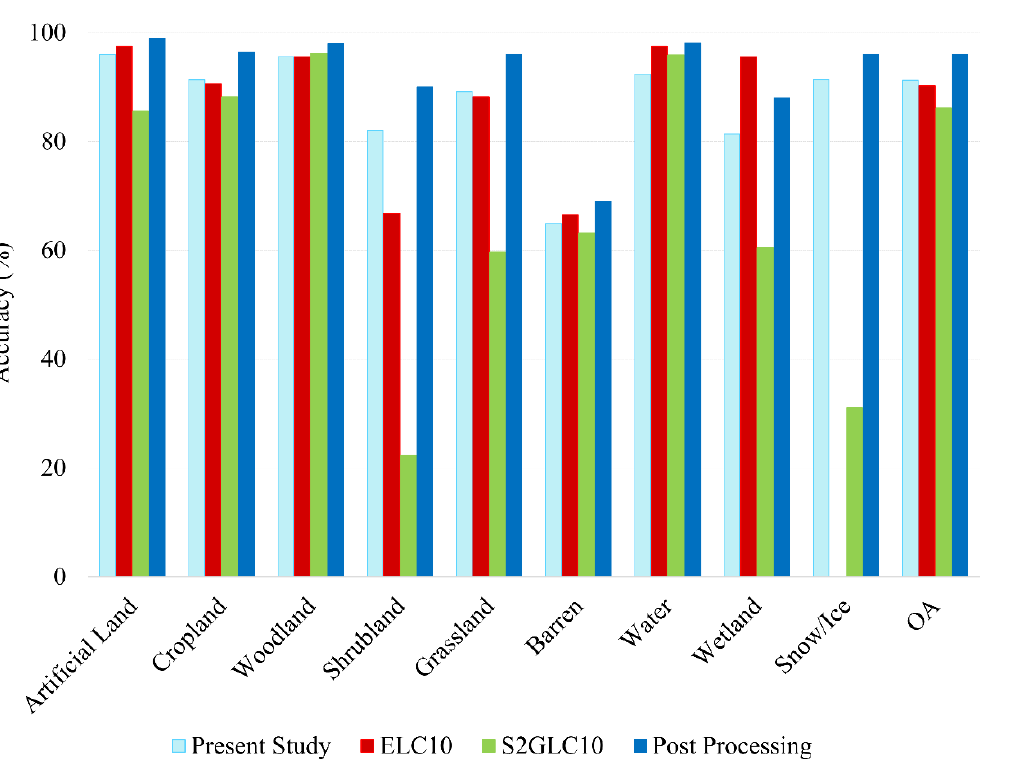
Figure 9. OAs and PAs of the nine LULC classes from the present study, ELC10, S2GLC10, and the present study (computed using [100,101] estimations) after